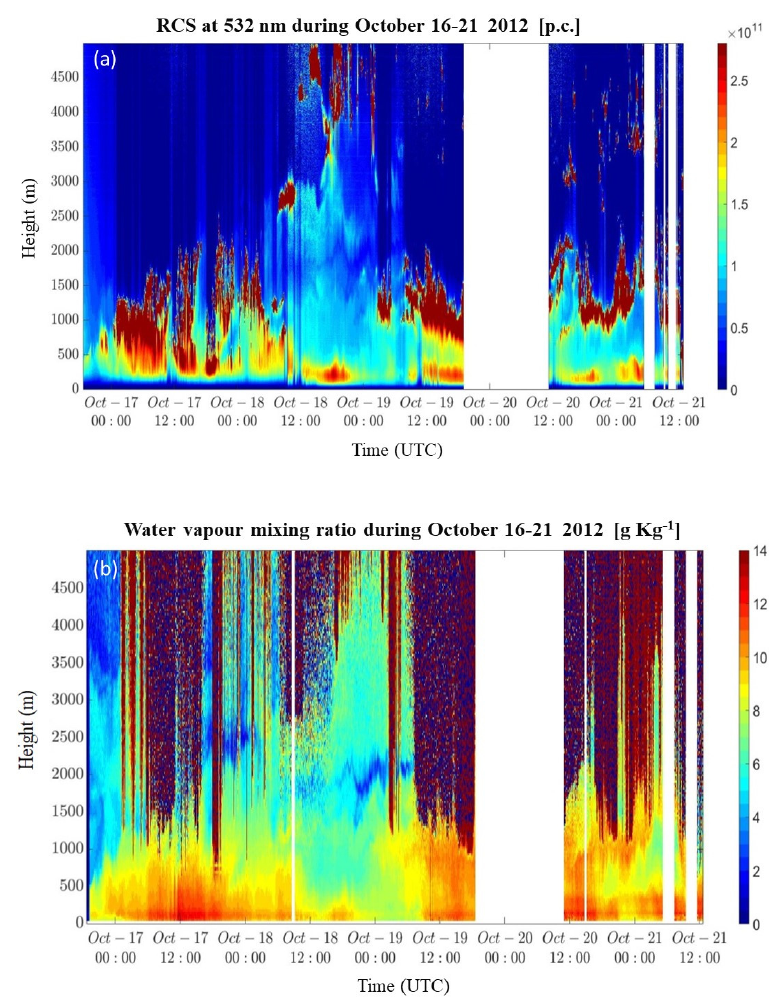
Figure 1. Time--height cross-section of the RCS at 532 nm ( a ) measured by Raman lidar BASIL and ( b ) water vapor mixing ratio over Cardillargues during 16–21October 2012. ( b ) water vapor mixing ratio over Cardillargues during 16–21 October